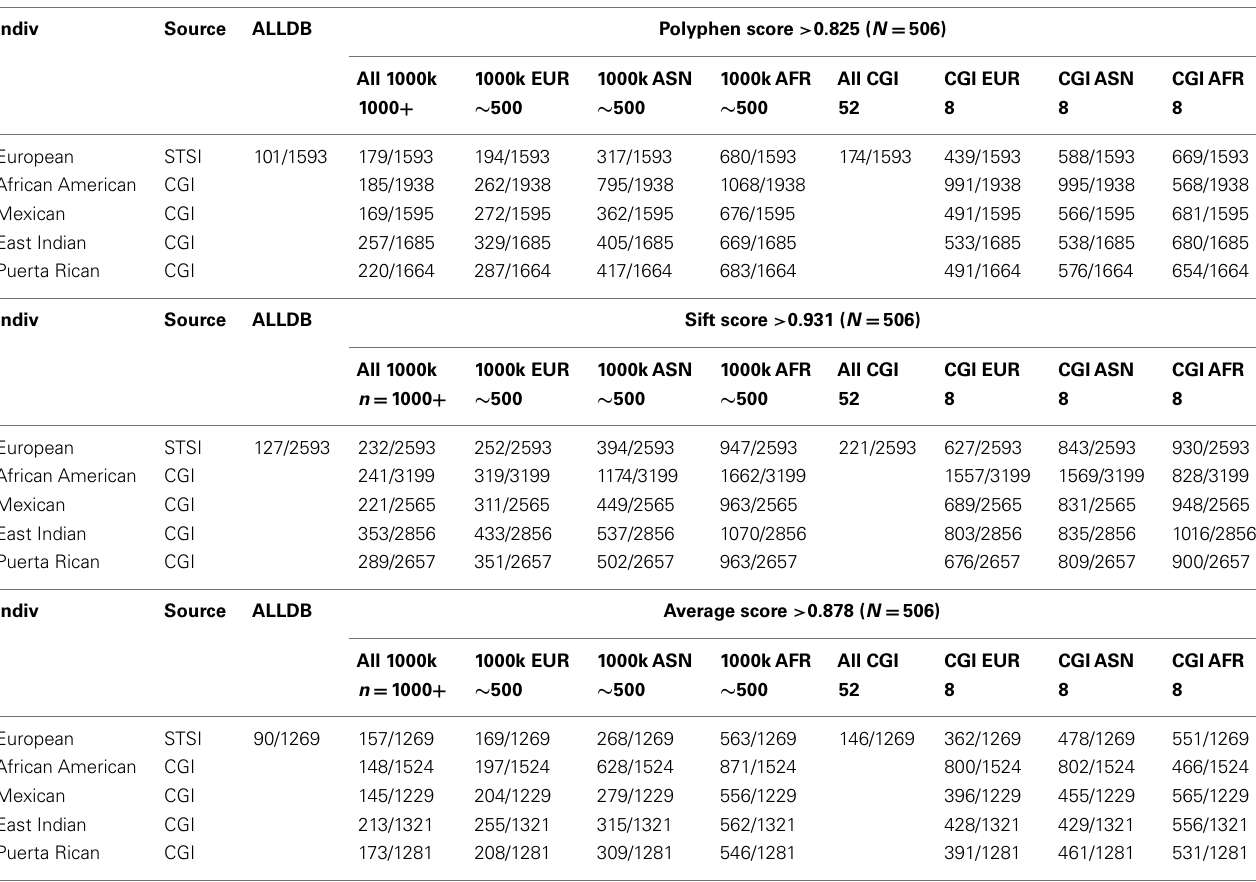
Table 4 |The number of ns cSNVs deemed “novel” with predicted functional consequence scores greater than that assigned a known CMT syndrome-inducing variant as function of the reference panel used for five individual genomes of diverse